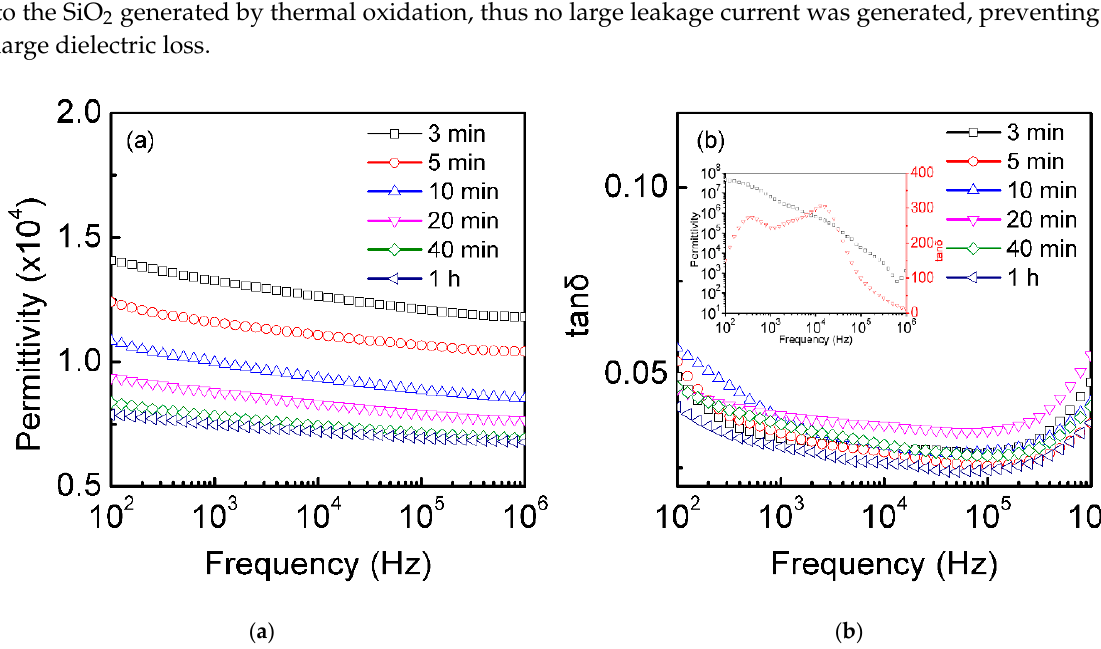
Figure 4. Frequency dependence of the dielectric properties at room temperature. Dielectric permittivity ( a ) and dielectric loss ( b ) of the single-crystalline silicon plates (0.7 mm) at different thermal oxidation times (3 min, 5 min, 10 min, 20 min, 40 min, and 1 h). The inset figure shows dielectric constant and dielectric loss of the raw single-crystalline silicon wafer (no thermal oxidation).